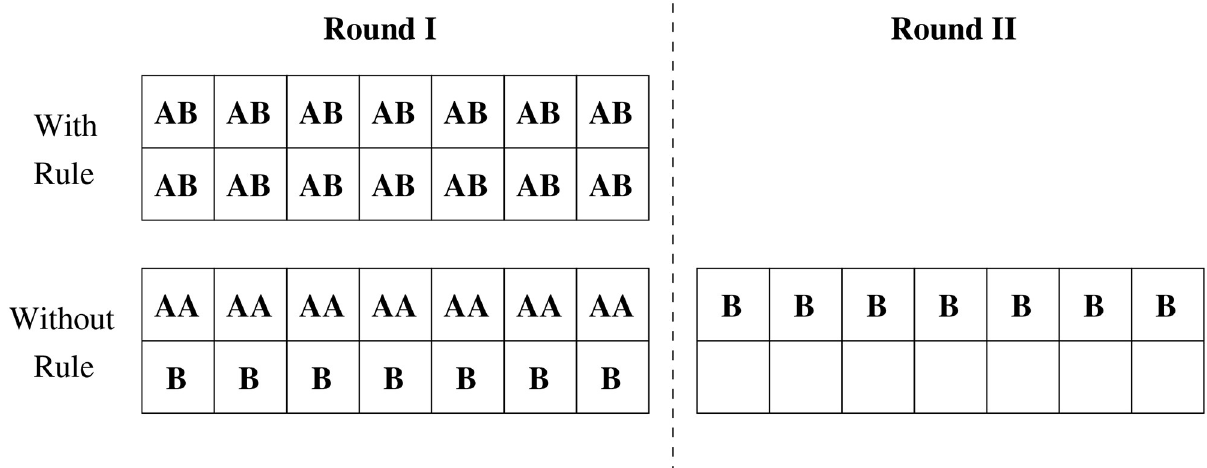
Fig 6. Two different ways to schedule two CUDA kernels, each of which is in a CUDA stream.